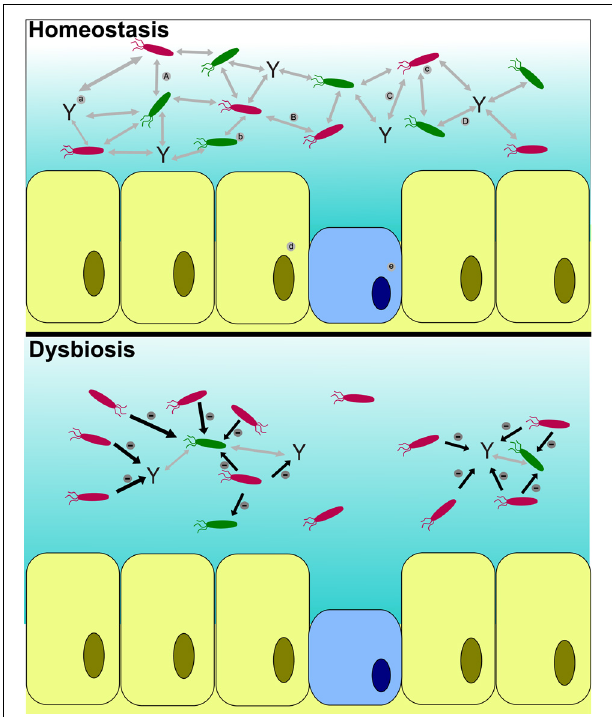
FIGURE 2 | Host microbiota interactions during homeostasis and dysbiosis. The host is able to control the pathogen (c) growth by different process (A,C) involving the immune response (a) and the resident microbiota (b). Furthermore, the immune response recognizes the resident microbiota (D) as non-pathogenic bacteria. Pathogenic bacteria auto-regulate abundance via quorum sensing (B) and can detect environmental signals from host cells [epidermic cells (d) and mucous cells (e)]. During dysbiosis, the pathogenic population, triggered by the stress response of the host (diminution of the immune response, production of mucus and diminution of the abundance of the resident microbiota), overcome the immune response and outcompete the resident